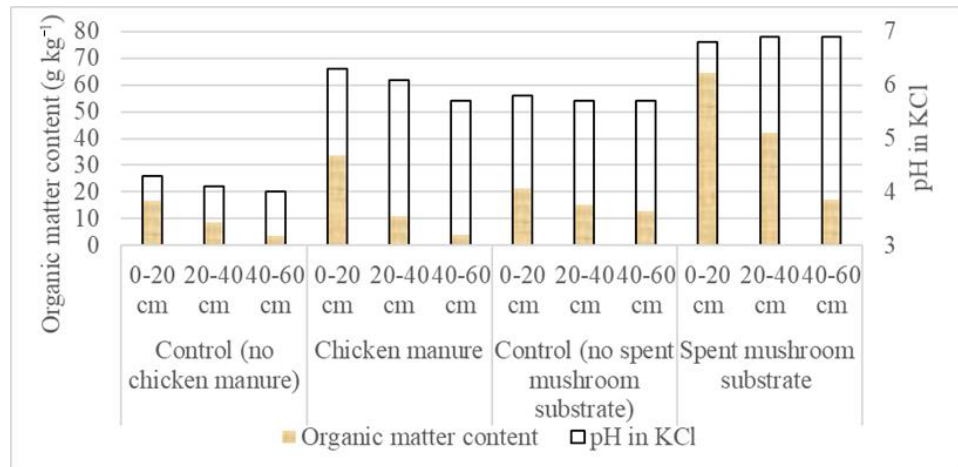
Figure 1. Soil organic matter content (yellow part of the bars) and pH (full length of the bars) of the control and chicken manure- and spent mushroom substrate-amended soils at depths of 0–20, 20–40, and 40–60 cm.